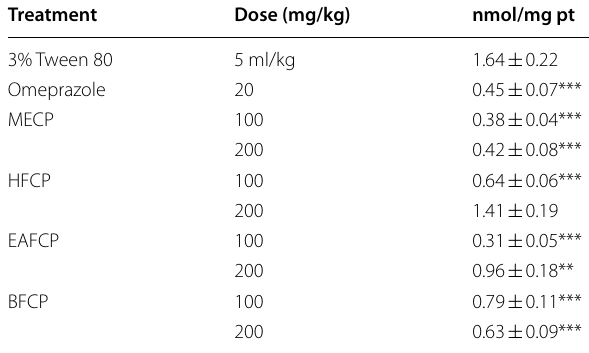
Table 6 Effect of methanol extract and fractions of C. paniculatum on gastric malondialdehyde levels